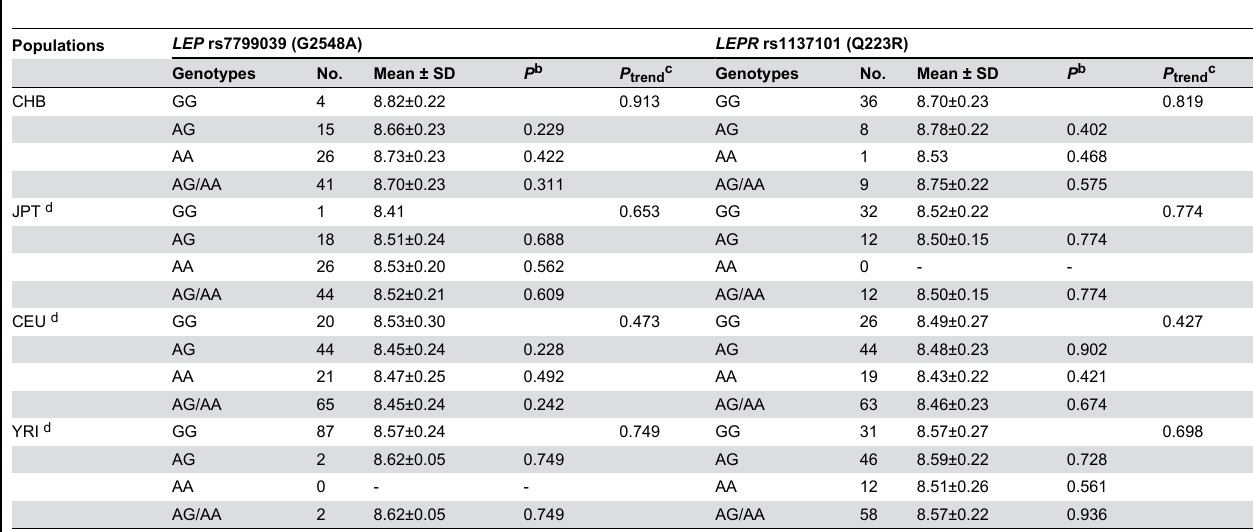
Table 4. LEP and LEPR mRNA expression by the genotypes of SNPs, using data from the HapMap a .